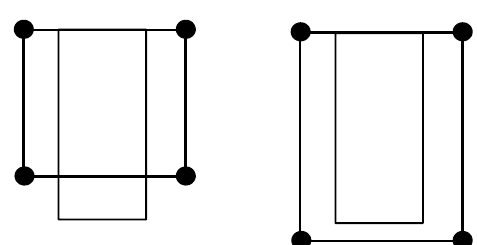
Figure 9. An example where we must increase the height of the drawing to resolve label overlaps.